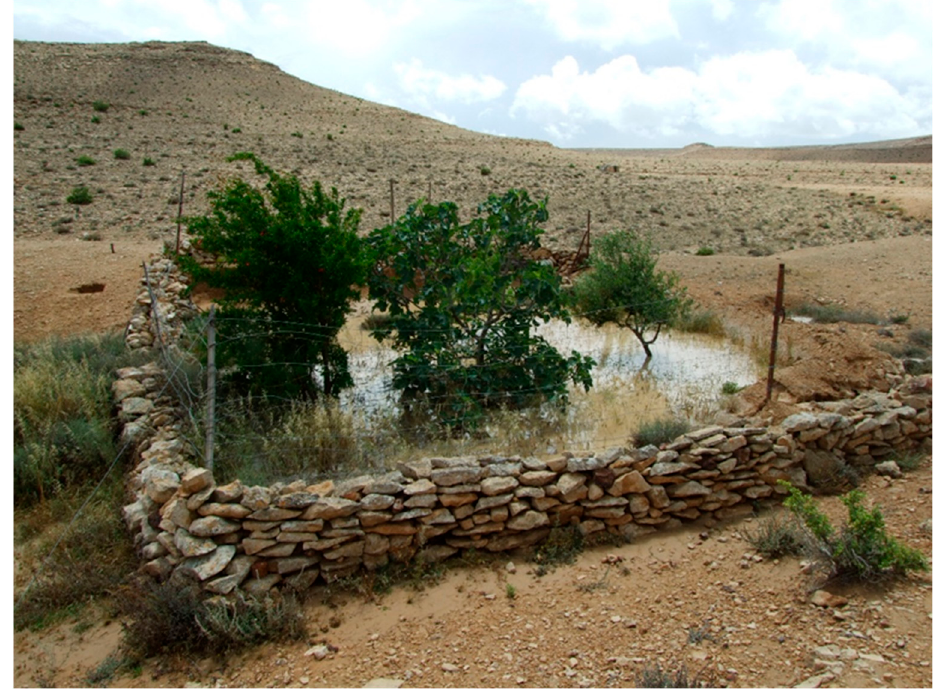
Figure 14. An experimental Type B agricultural terrace plot constructed at the southern fringe of the ancient agricultural zone in the Negev Highlands. (Photograph: Y.